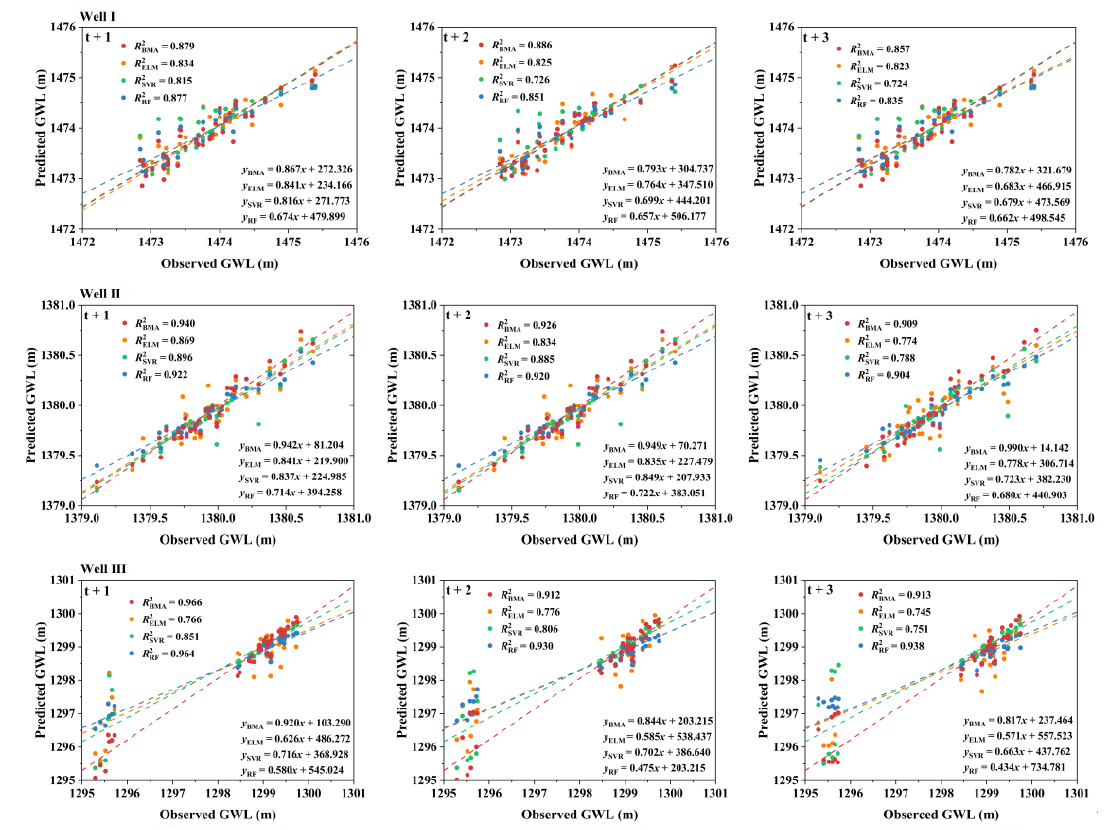
Figure 3 . Scatter plot of the observed and predicted GWL obtained by the ELM, SVR, RF, and BMA models for Wells I, II, and III at 1-, 2-, and 3-month-ahead prediction horizons in the testing period.